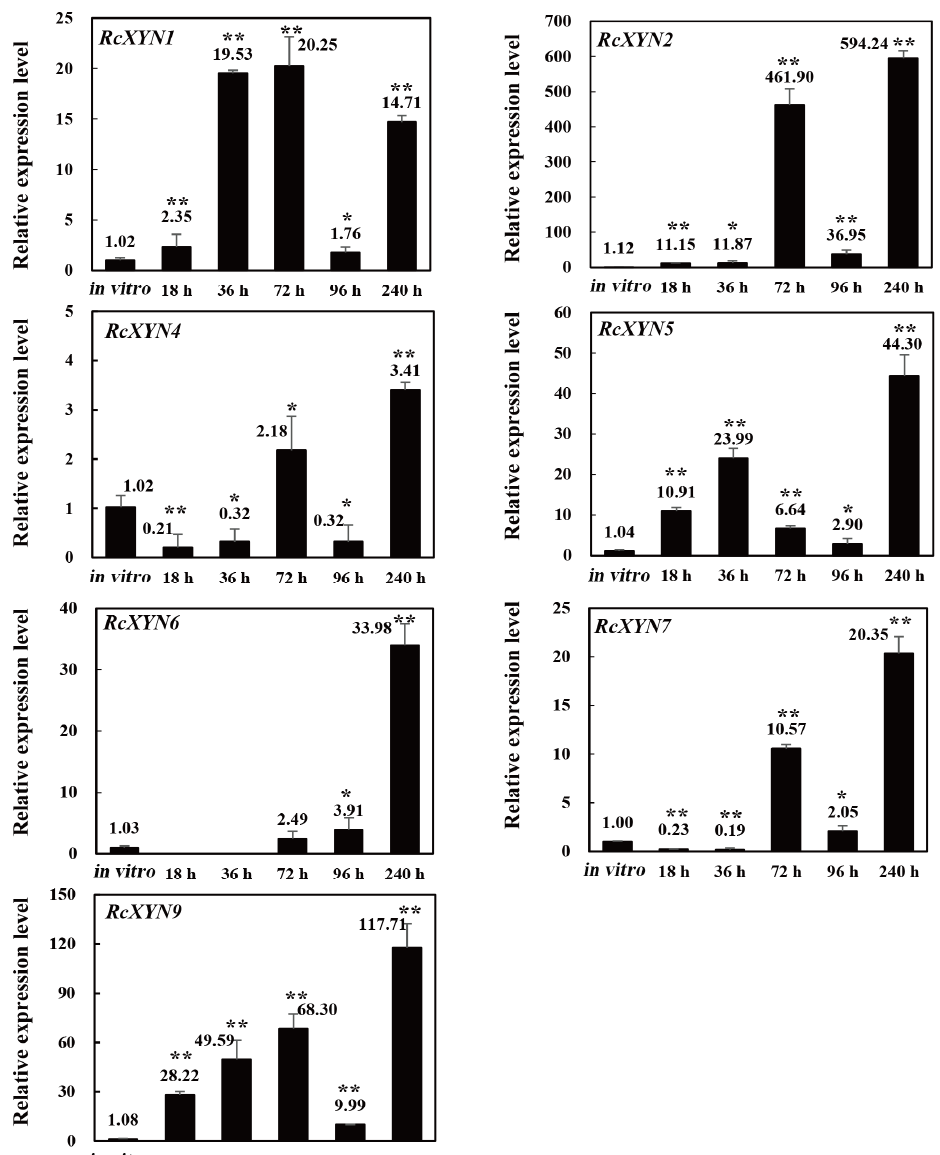
Figure 4. Expression patterns of the nine RcXYN genes in R. cerealis during the infection process of wheat stems. The R.cerealis Actin gene was used as an internal control to normalize cDNA. The expression of each xylanase gene was investigated during the infection process of wheat stems, including five di ff erent infection time points (18, 36, 72, 96, and 240 h after inoculation, hai) and compared to that of mycelia cultured in vitro. Error bars were calculated based on three replicates. * and ** indicate significant di ff erences between R. cerealis -inoculated samples and in vitro samples ( t -test; * p < 0.05 and ** p < 0.01).